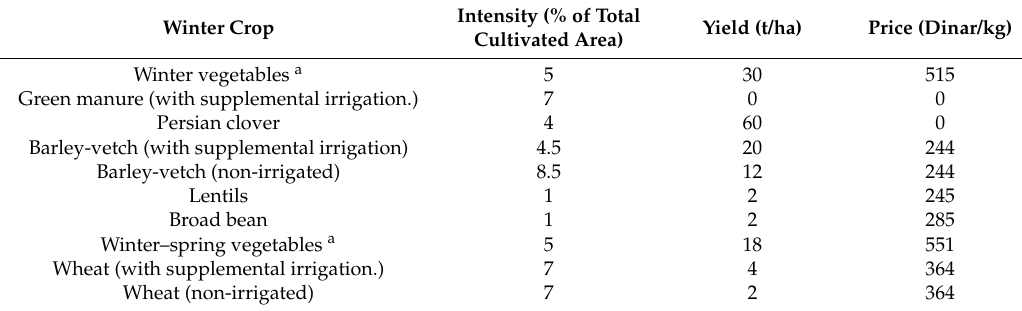
Table A3. The suggested cultivation patterns, yields, and prices for winter crops.